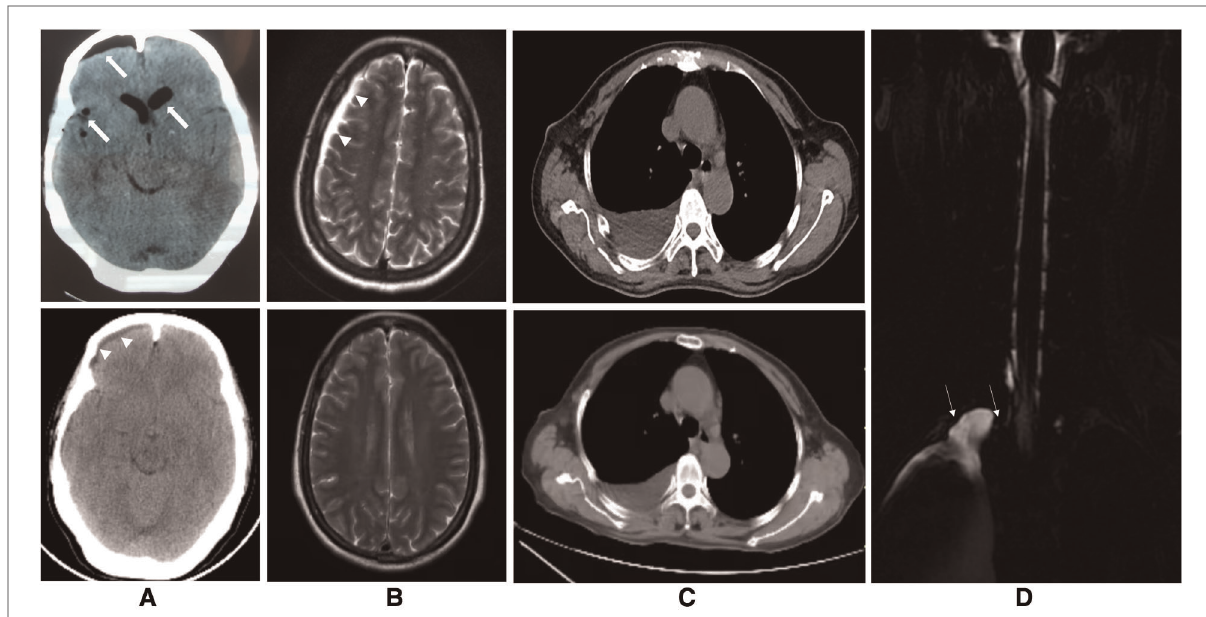
FIGURE 2 Images of the brain, chest and spine. ( A ) The upper fi gure of the axial computed tomography (CT) showing pneumocephalus in the cranial cavity of the lateral ventricle and right frontal, parietal and temporal and ventricular dilatation 5 days after the thoracoscopic surgery ( thick arrows ) and the lower fi gure showing resolution of these fi ndings and presence of right frontal subdural effusion 25 days after the thoracoscopic surgery ( arrowheads ). ( B ) The upper fi gure of axial T2-weighted magnetic resonance imaging of the brain showing subdural hematomas in the left frontal region, right frontotemporal parietal occipital region before the epidural blood patch (EBP) therapy ( arrowheads ) and the lower fi gure showing complete absorption of these subdural hematomas 2 months after EBP therapy. ( C ) The upper fi gure of axial chest CT demonstrating a moderate amount of right-sided pleural effusion before the EBP therapy and the lower fi gure showing decrease of it 2 months after EBP therapy. ( D ) T2- weighted magnetic resonance myelography imaging of the spine showing subarachnoid-pleural fi stula connection of the left pleural effusions and the spinal canal before EBP therapy ( white arrow